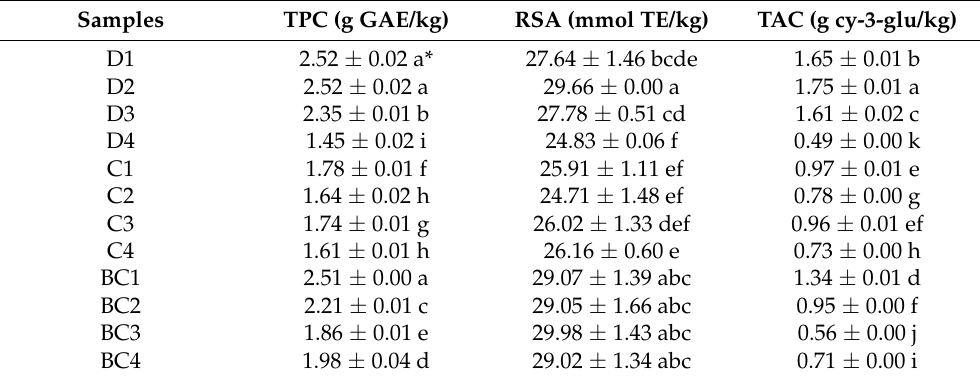
Figure 3. Significant interaction effect of cultivar × harvest date for fruit weight ( A ); fruit shape index ( B ); the content of total acids ( C ); and soluble solid/total acid ratio ( D ). Table 5. Total phenolic content, radical-scavenging activity, and total anthocyanin content of blueberry